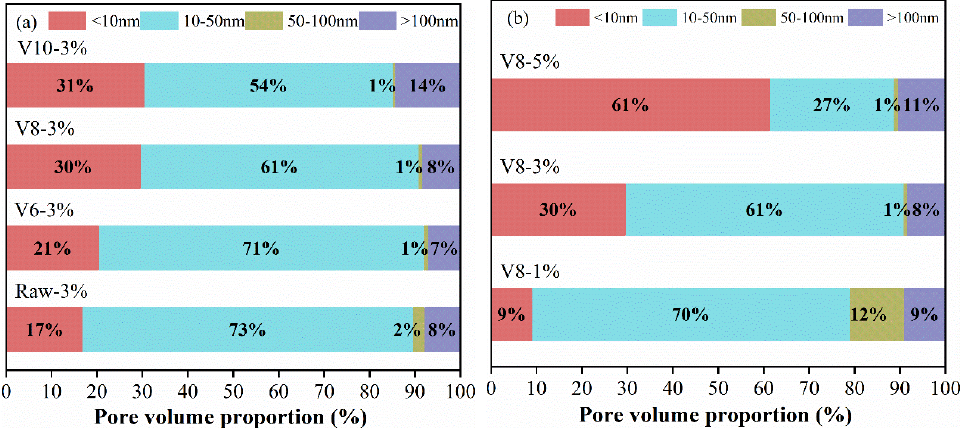
Figure 12. Cumulated pore-size distribution of hardened specimens at 28 d: effect of BFS fineness ( a ) and effect of NC dosage ( b ).